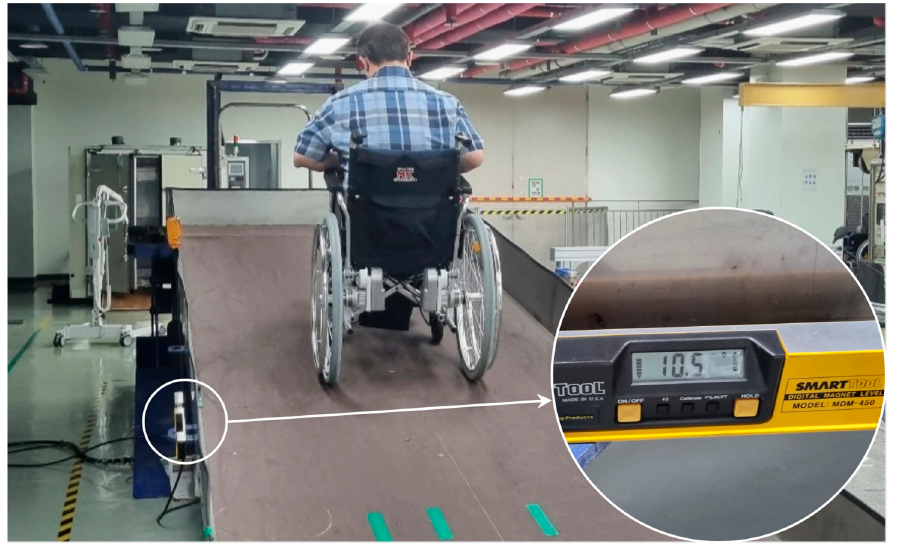
Figure 10. Slope climbing test for the wheelchair. Appl. Sci. 2023 , 13 , x FOR PEER REVIEW